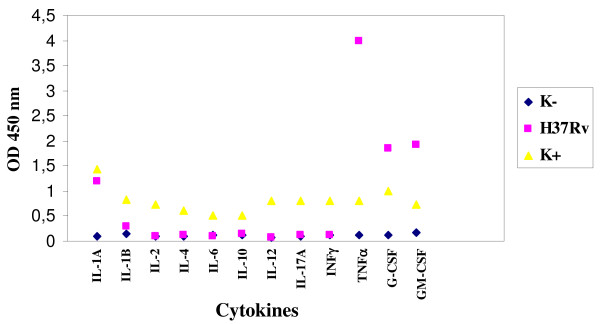
Expression of cytokines by microglial cells BV-2 infected by M. tuberculosis H37Rv.